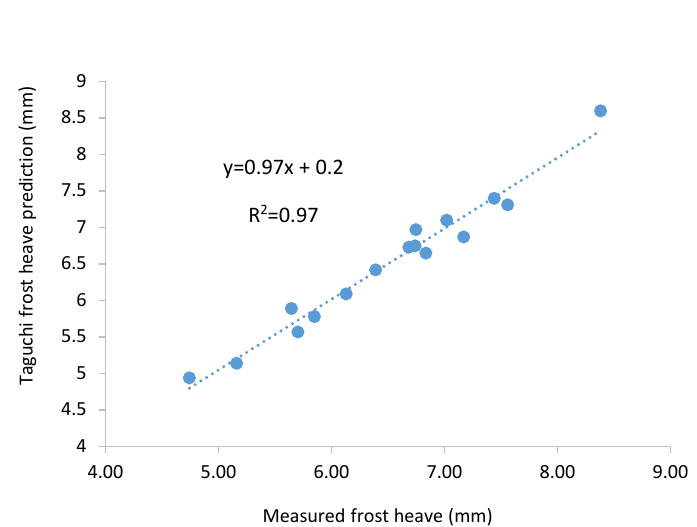
Fig. 5: Results of frost heaves measured versus Taguchi predictions